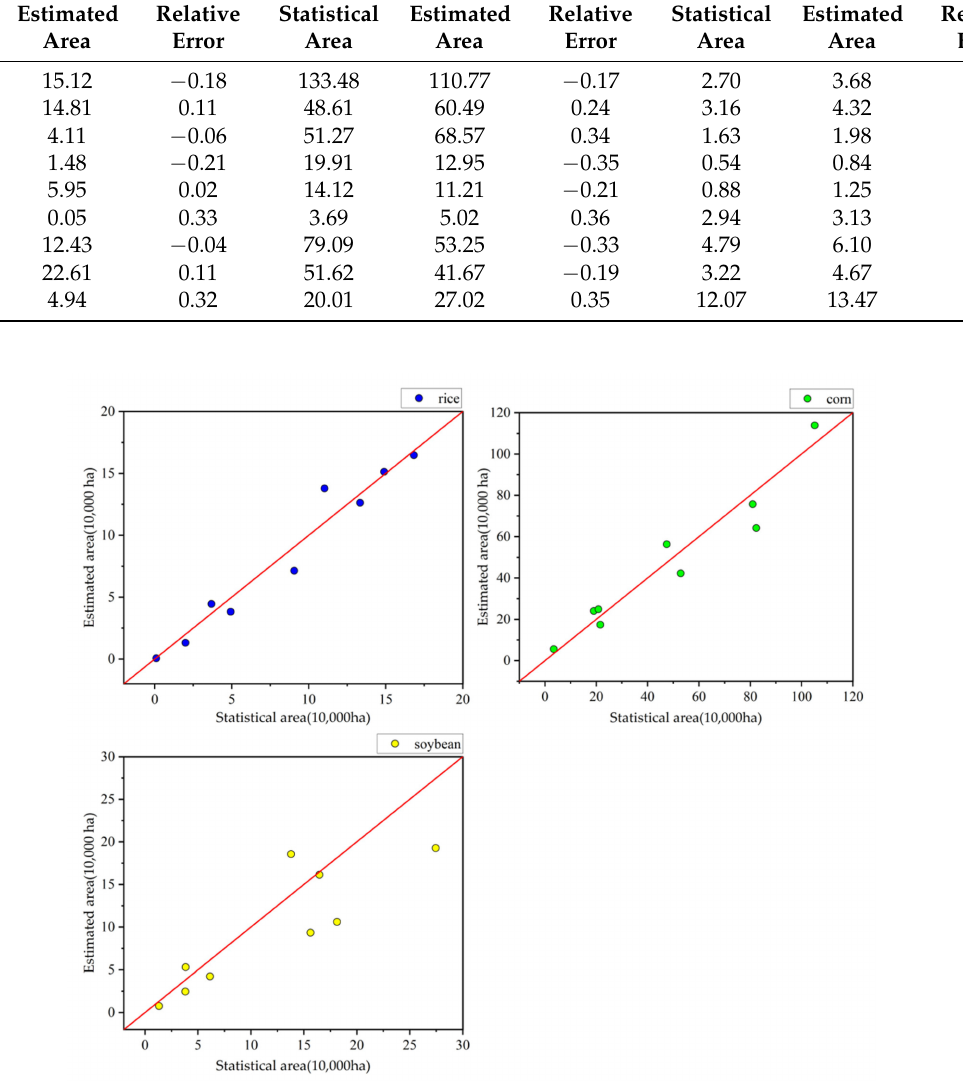
Figure 8. Comparison of the estimated area and the statistical data for rice, corn, and soybean in the study area in